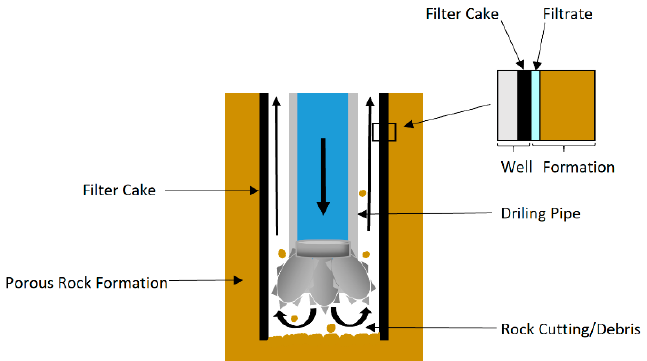
Figure 10. The scheme of drilling fluid circulation during the drilling process.